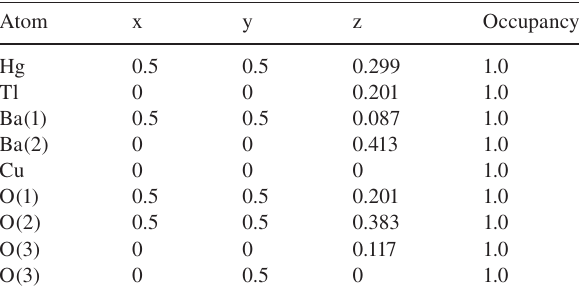
Table 4 Structural parameters used for image calculation of HgTlBa CuO 2 5